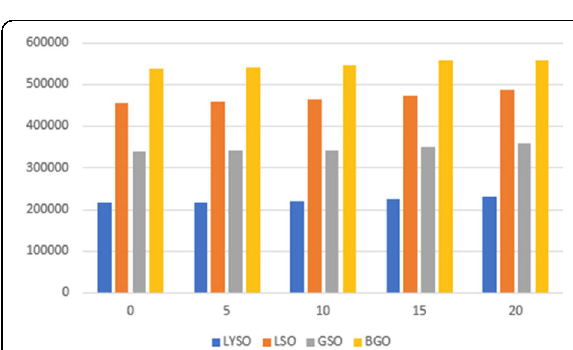
Fig. 2 (abstract A31). Count rate for BGO, GSO, LSO and LYSO crystals in pixelated